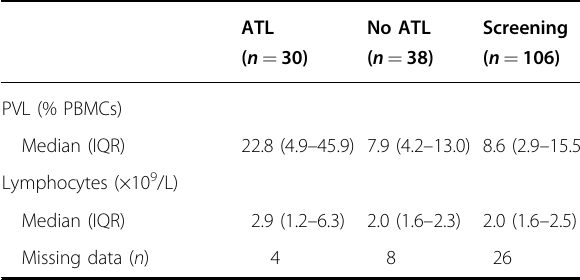
Table 1 Baseline demographic and clinical data from each